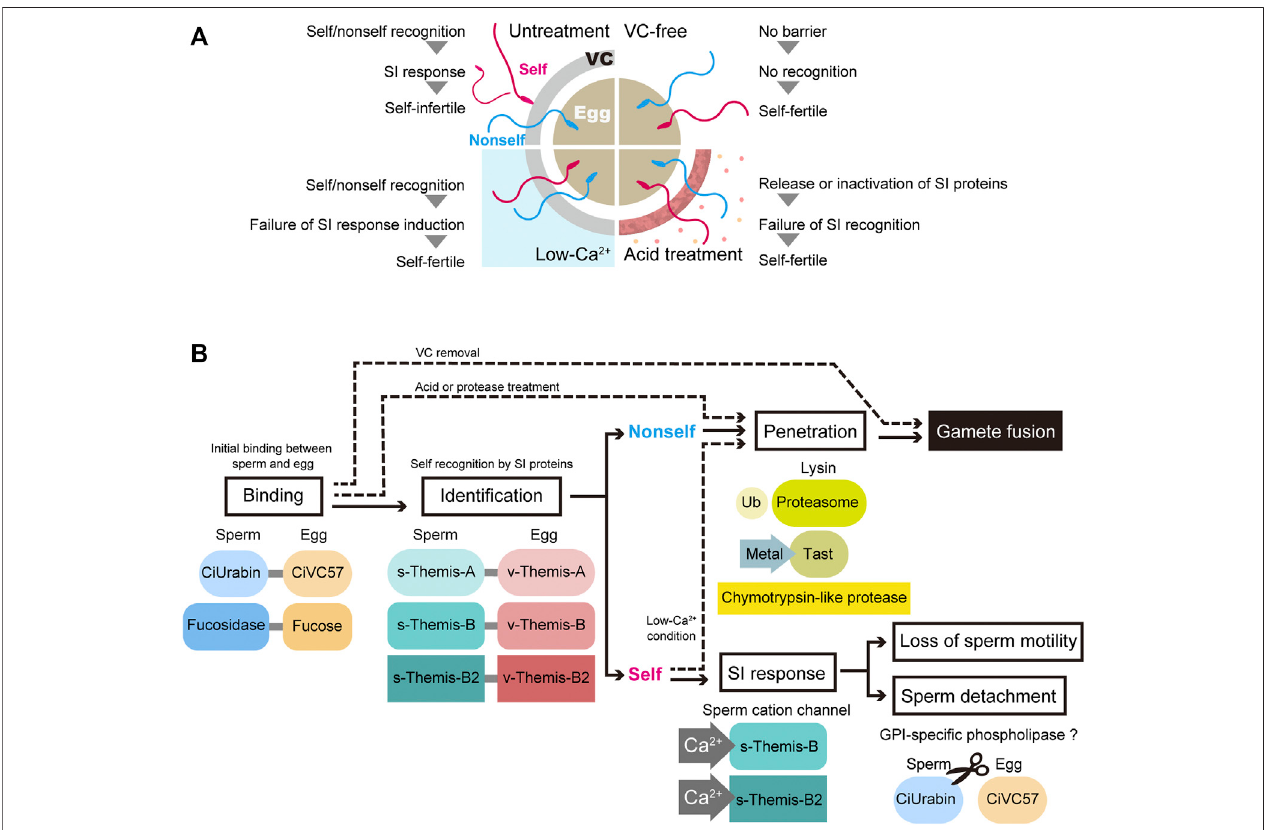
FIGURE2| Currentstatusoffertilizationandself-incompatibilitysystem. (A) Schematicrepresentationofarti fi cialself/nonself-fertilizationin C.intestinalis. Thereare severalwaystoachievearti fi cialself-fertilization.RemovingtheVCandtreatingtheVCwithacidicseawaterorproteasesrelievestheself-fertilizationblock.Inaddition,the inhibition of Ca 2+ in fl ux in spermatozoa, which is controlled by the external Ca 2+ concentration, is suf fi cient to block the self-fertilization signal. (B) Gamete proteins involved in each step of fertilization are illustrated. Ub, ubiquitin; Tast, tunicate astacin-like metalloprotease with thrombospondin-type-1 repeat.